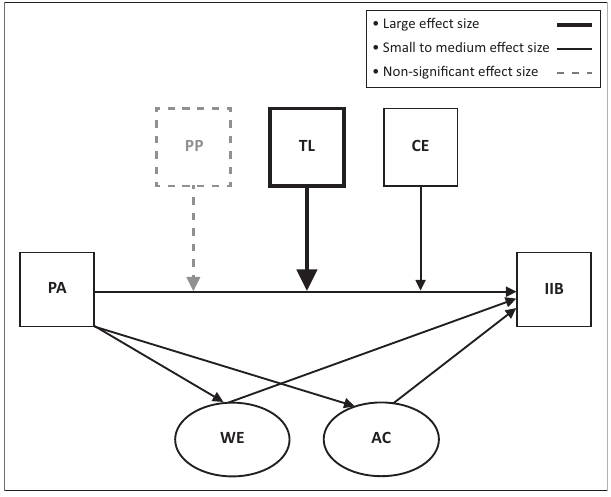
FIGURE 2: Revised performance appraisal-innovation model with mediators and